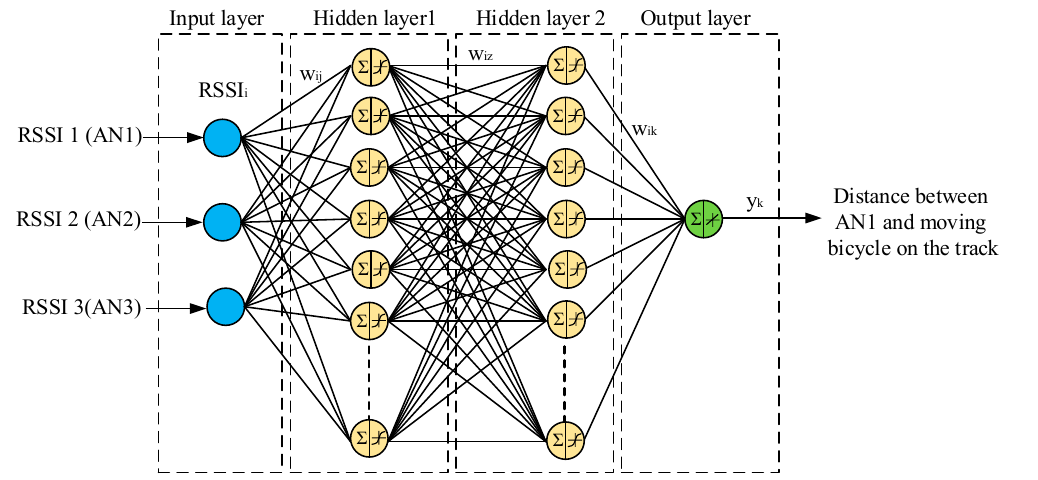
Figure 8. The architecture of the ANN algorithm.